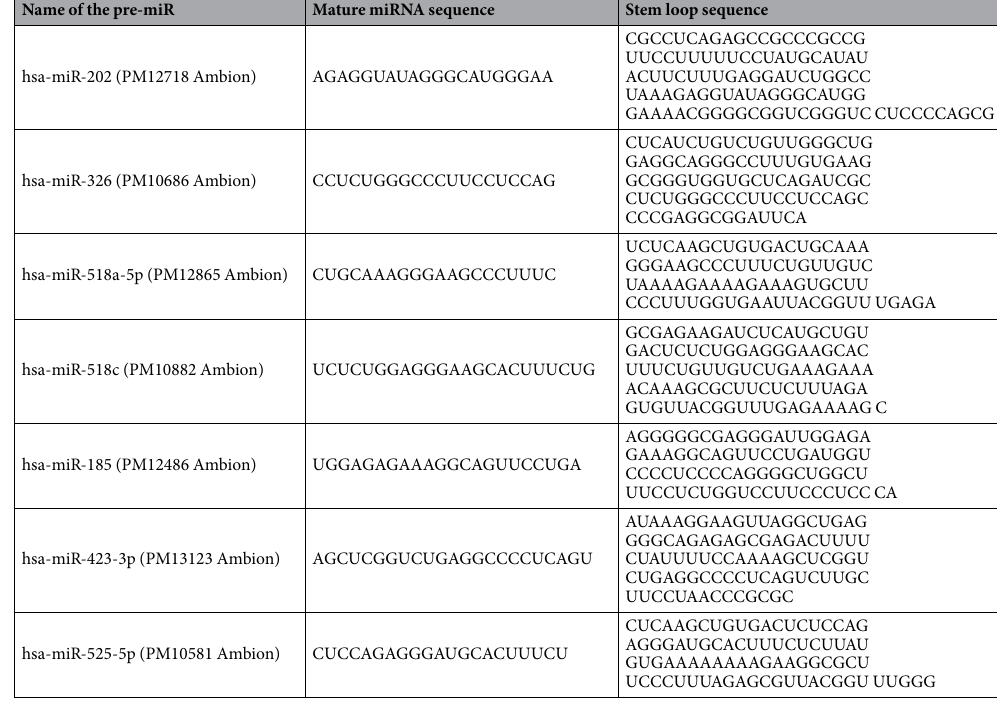
Table 3. Sequences of pre-miRNAs transfected in the keratinocytes (Sequences provided in the package inserts of Ambion